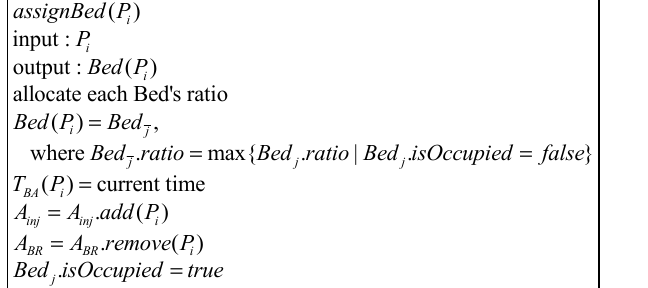
Figure 5. Bed allocation algorithm.